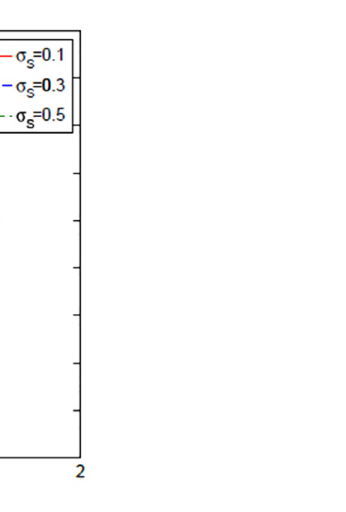
Fig 13. The effects of σ S on the optimal decision boundary.